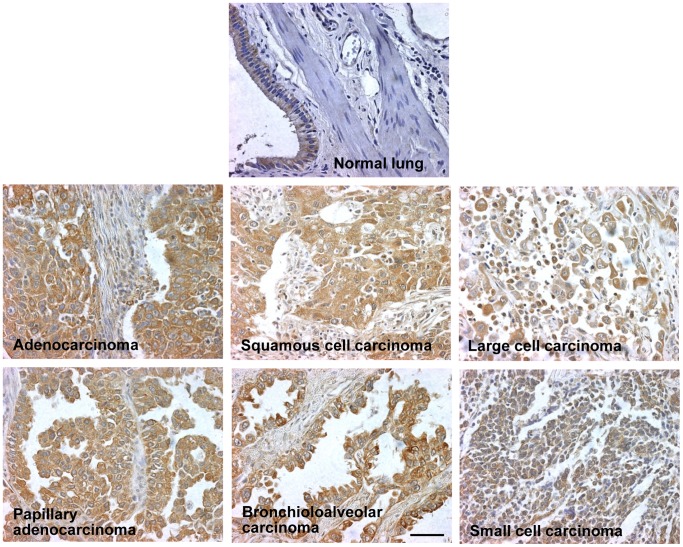
ACSVL3 expression in normal human lung and lung tumors by immunohistochemistry.Paraffin sections of lung tumors present on a tissue array were immunostained with anti-ACSVL3 antibody (brown) and counterstained with hematoxylin (blue). Tumors representative of the 67 different tumors present on the array, as well as normal lung tissue, are shown. All tumors stained positive for ACSVL3. Total magnification, 400×. Bar = 50 µm.